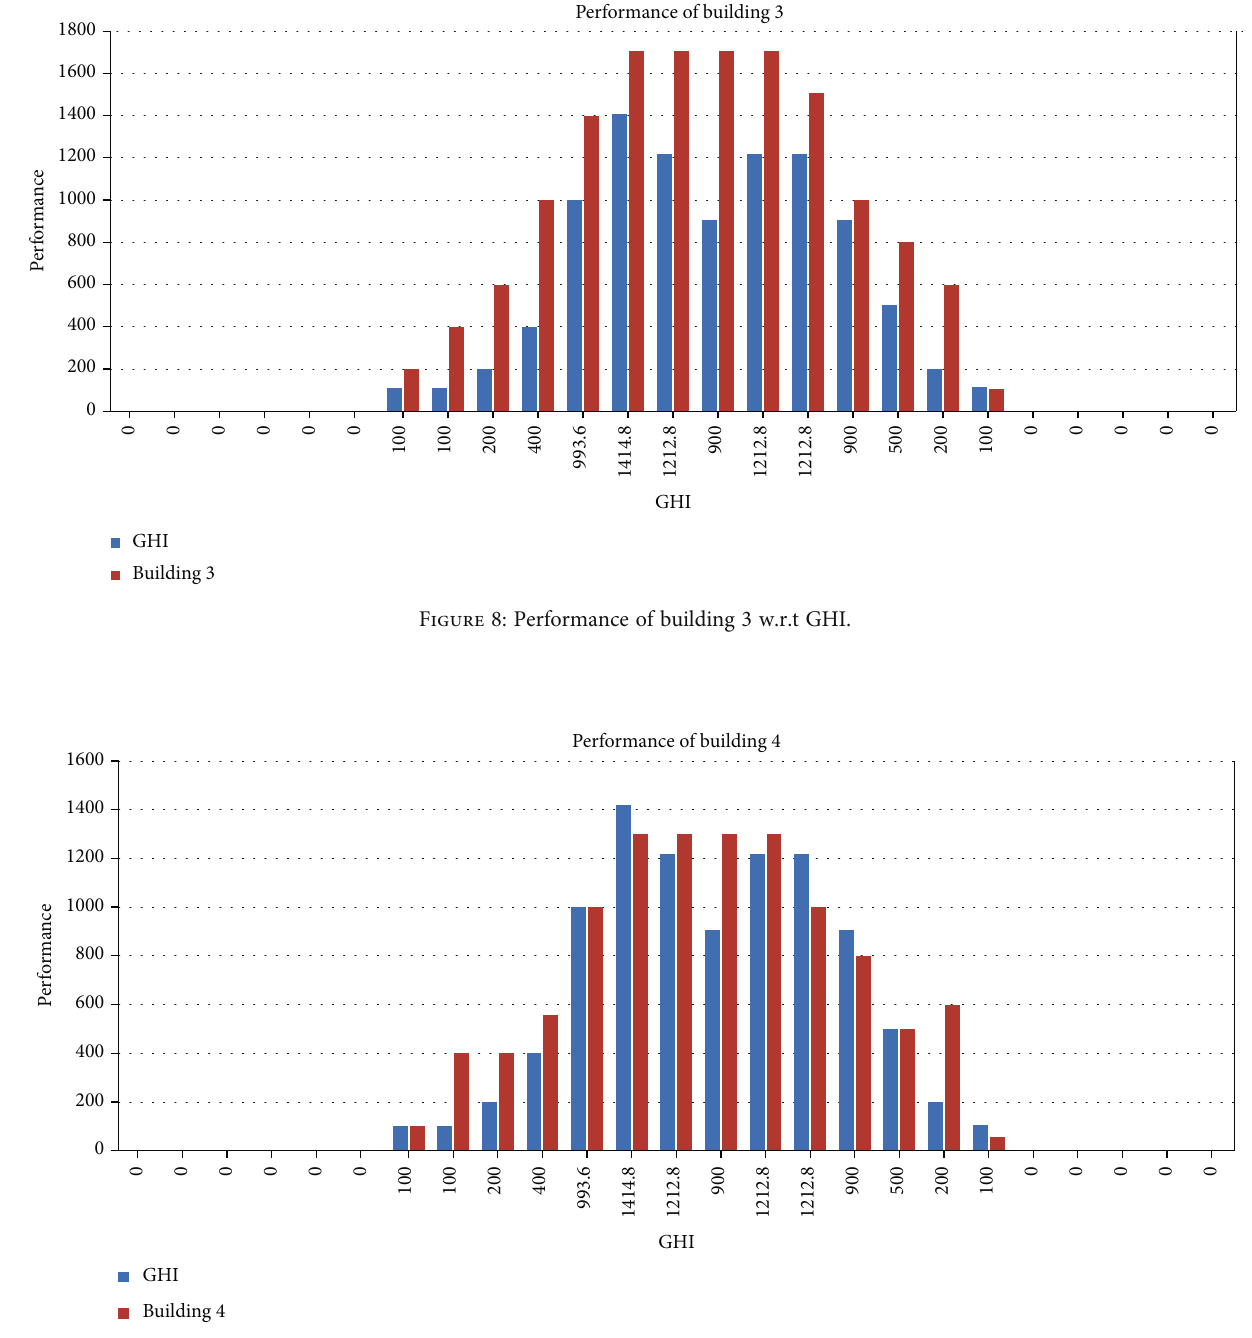
Figure 9: Performance of building 4 w.r.t